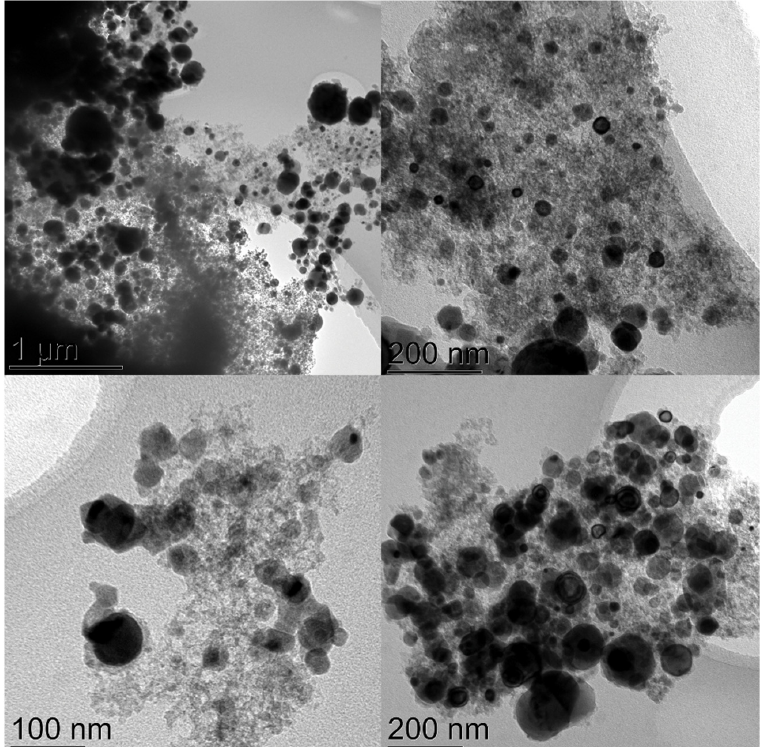
Figure 7. Transmission electron micrographs of a sample of hydrolysis lignin coated with nickel compounds (7% wt.) after gasification.